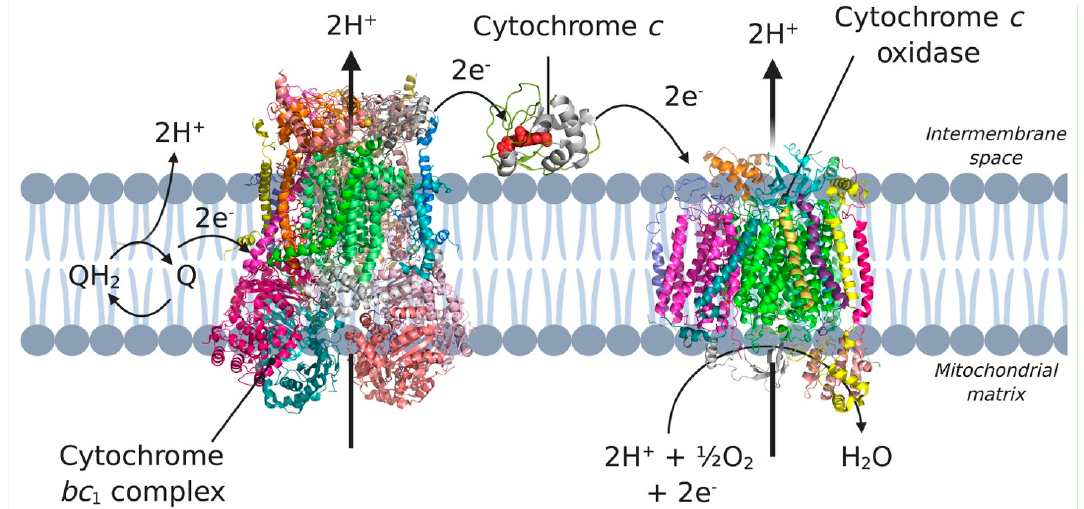
Figure 6. Complex III, complex IV and cytochrome c in the electron transport chain. Electrons coming from complex I and II are transferred to ubiquinone (Q) in the membrane. Subsequently, the electrons are transferred to complex III, cytochrome c , and complex IV, which eventually incorporates the electrons in water. 3D structural cartoons of the Homo sapiens cytochrome bc 1 (PDB:5XTE) [89], the Homo sapiens cytochrome c oxidase (PDB:5Z62) [90], and the yeast cytochrome c (PDB:4Q5P) [91] were rendered using PyMol and the figure compiled using BioRender.com